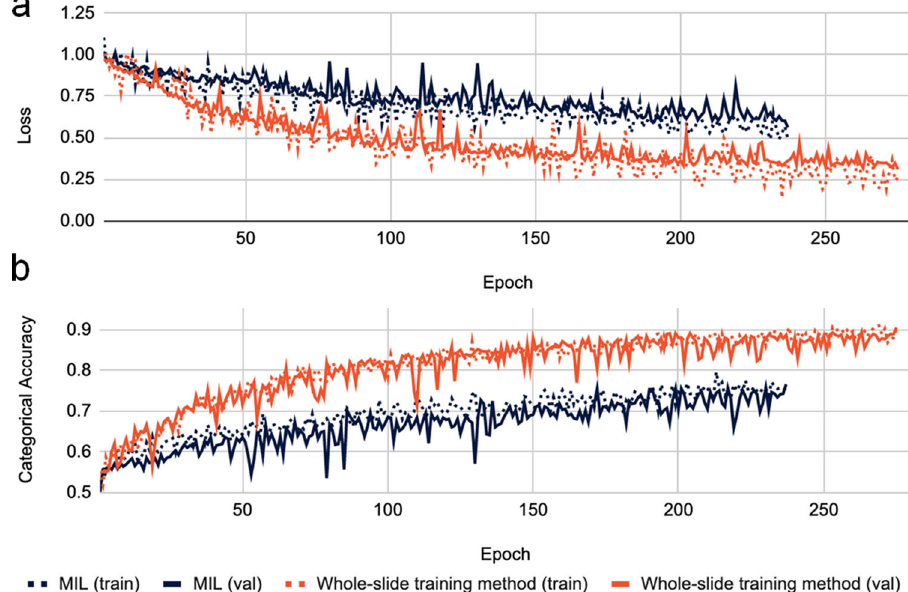
Fig. 3 Learning curves of MIL and whole-slide training method. The lines represent the loss ( a ) and the accuracy ( b ) of MIL (dark blue) and whole-slide training method (red) for the training set (dotted) and the validation set (solid). The x axis represents the numbers of elapsed training